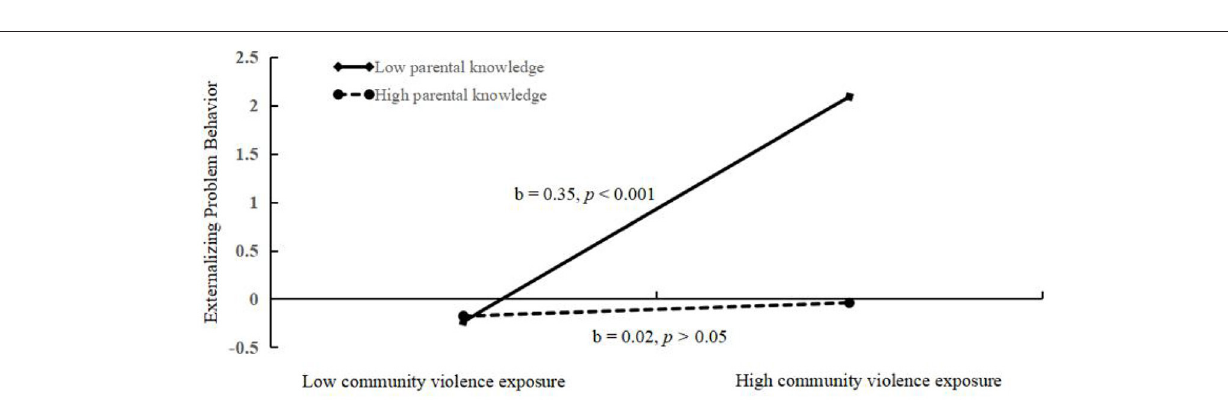
FIGURE 4 | Association between community violence exposure and externalizing problem behaviors at higher and lower levels of adolescent parental knowledge (Before add covariate: school climate).